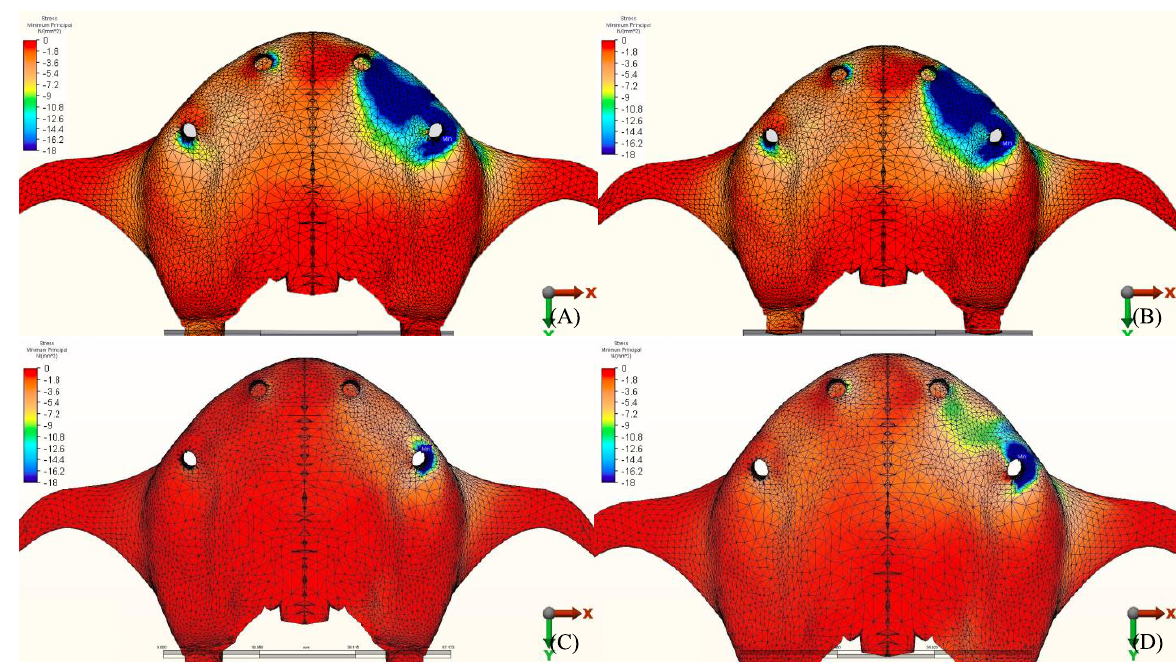
Figure 9. Pmin stress distribution in cortical bone for group 1, titanium bar with acrylic teeth. ( A ) Model 1.1, opposing natural tooth. ( B ) Model 1.2, opposing tooth-supported full ceramic crown. ( C ) Model 1.3, opposing acrylic prosthesis with titanium framework. ( D ) Model 1.4, opposing implant-supported full ceramic crown.